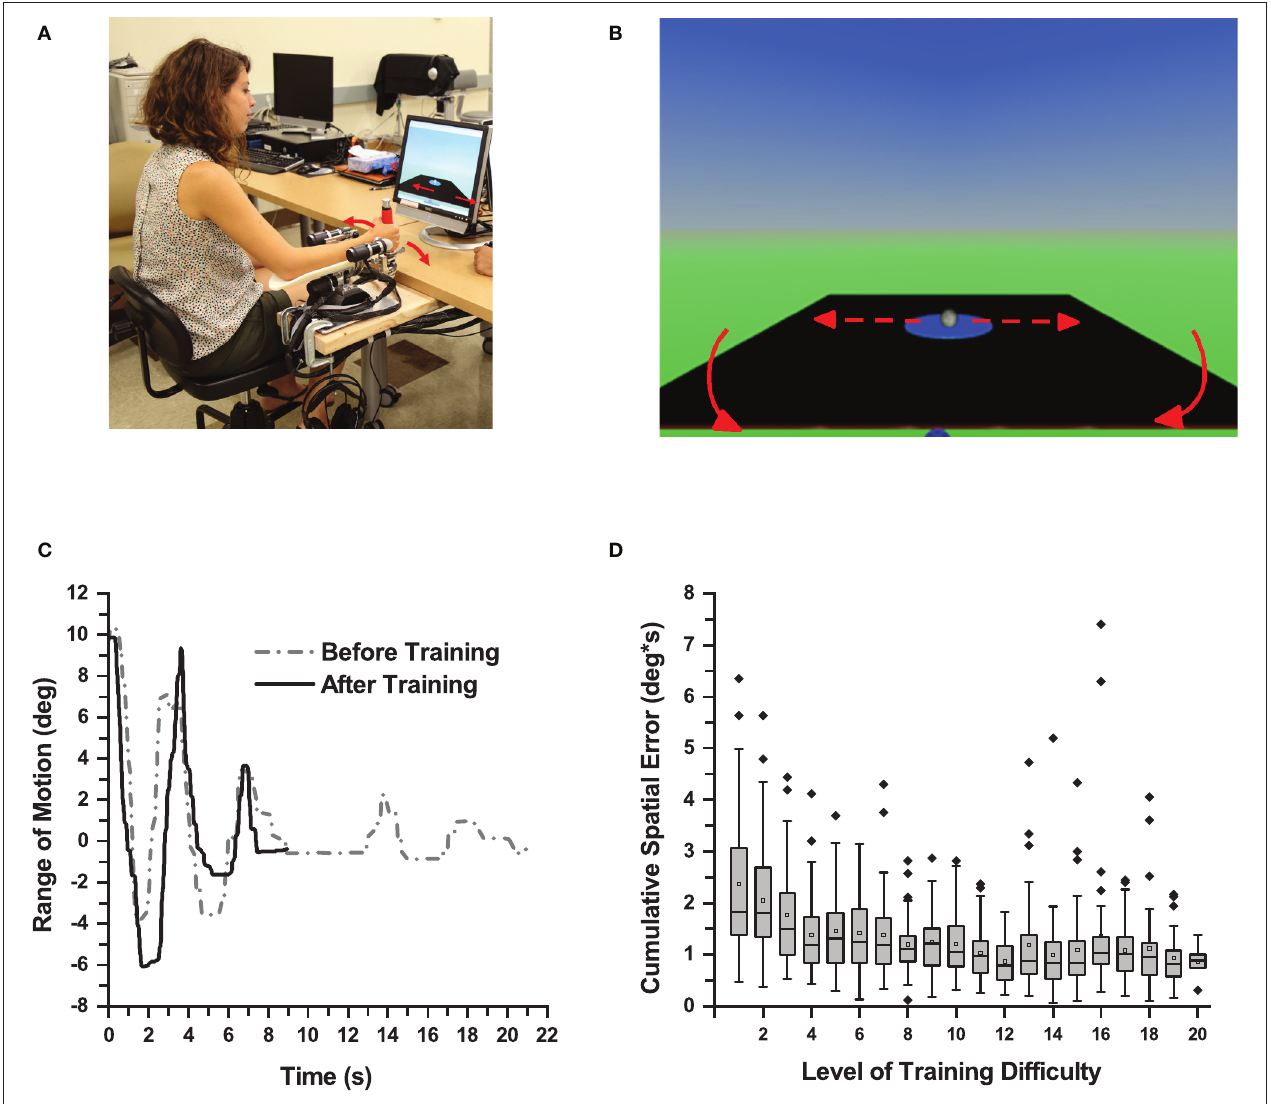
FIGURE 1 | Proprioceptive Training. (A) Participant performing a training trial using the WristBot (Media consent provided by the participant for publication). (B) Monitor screenshot displaying the virtual table and the virtual ball. The participant wrist movement caused the table to tilt resulting in displacement of the ball. (C) Wrist displacement of one participant during a trial before and after training. After training, the participant produced larger displacement and shorter duration to complete a trial in this balancing task. (D) Box plot showing cumulative spatial error of all participants across all levels of training difficulty. As participants achieved higher levels of training difficulty, the cumulative spatial error in each level decreased for the all participants demonstrating motor